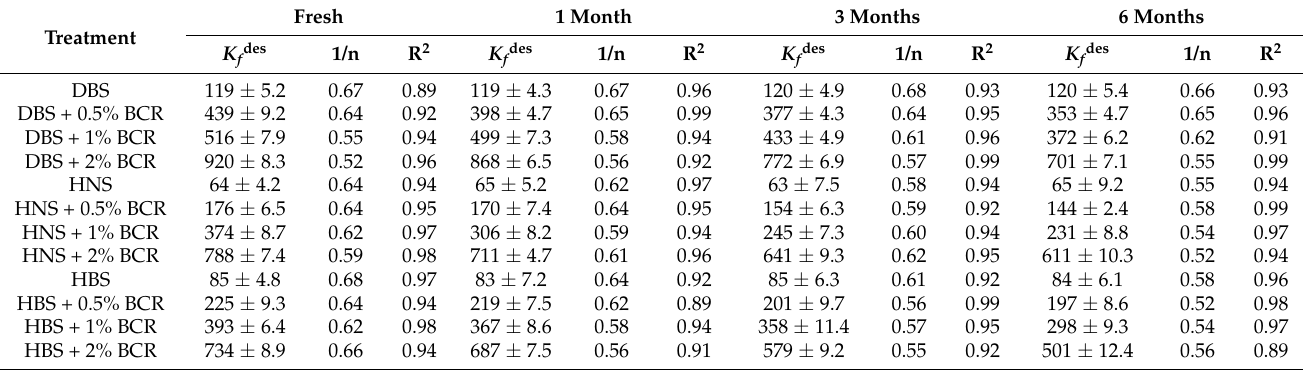
Table 2. Parameters values of oxyfluorfen desorption in unamended and biochar-amended soils fitted with Freundlich isotherm model. Data are expressed as the mean values ± SE (standard error). Fresh 1 Treatment